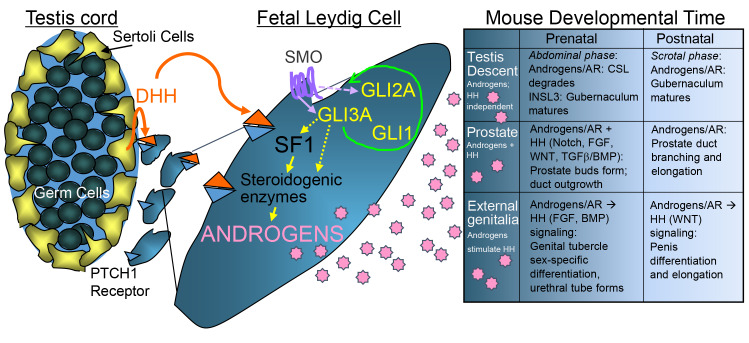
GLI3A and androgens cooperate to promote male reproductive tract maturation.Sertoli cells produce DHH, which diffuses to the testis interstitium where it interacts with PTCH1 receptors to stimulate fetal Leydig cell differentiation. Bound PTCH1 releases SMO to stabilize the activated GLI3 transcription factor (GLI3A), likely along with GLI2A, which indirectly (dashed arrow) stimulates Sf1 (Nr5a1) and other steroidogenic genes to initiate androgen production. Fetal Leydig cells produce androstenedione, which is converted to testosterone in Sertoli cells. GLI3A is necessary to maintain fetal Leydig cell identity by promoting the fidelity of both the hedgehog and steroidogenic enzyme pathways (green loop arrow). Testosterone is released into fetal circulation to promote testis descent, prostate and external genitalia formation (detailed descriptions in Box). Each downstream developmental event needs discrete levels of testosterone at specific times. While both abdominal and scrotal phases of testis descent are independent of HH signaling, prostate and external genitalia development both require HH. Prenatal prostate buds can form with minimal androgen exposure and without HH; although, elevated levels of each are likely important for later developmental stages. Male genital tubercle development is initiated by activated AR, which in turn, stimulates an increase in production of HH and other signaling factors. Gli3XtJ mutant embryos are embryonic lethal precluding analysis of postnatal development; however, our analysis of male sex characteristics during prenatal development highlight cooperation and interactions between androgen/AR and HH signaling pathways.